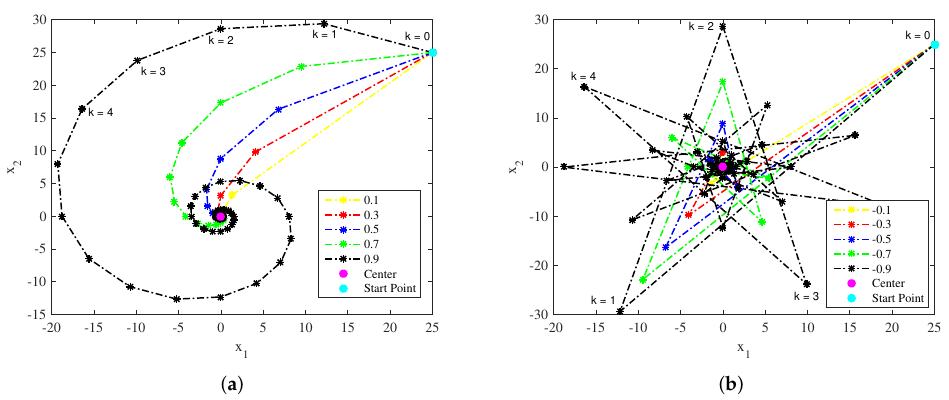
Figure 1. Spiral trajectories for a two-dimensional system for various values of r ∈ [ − 1,1 ] and θ = π ( a ) conventional spiral and ( b ) hypotrochoid spiral.